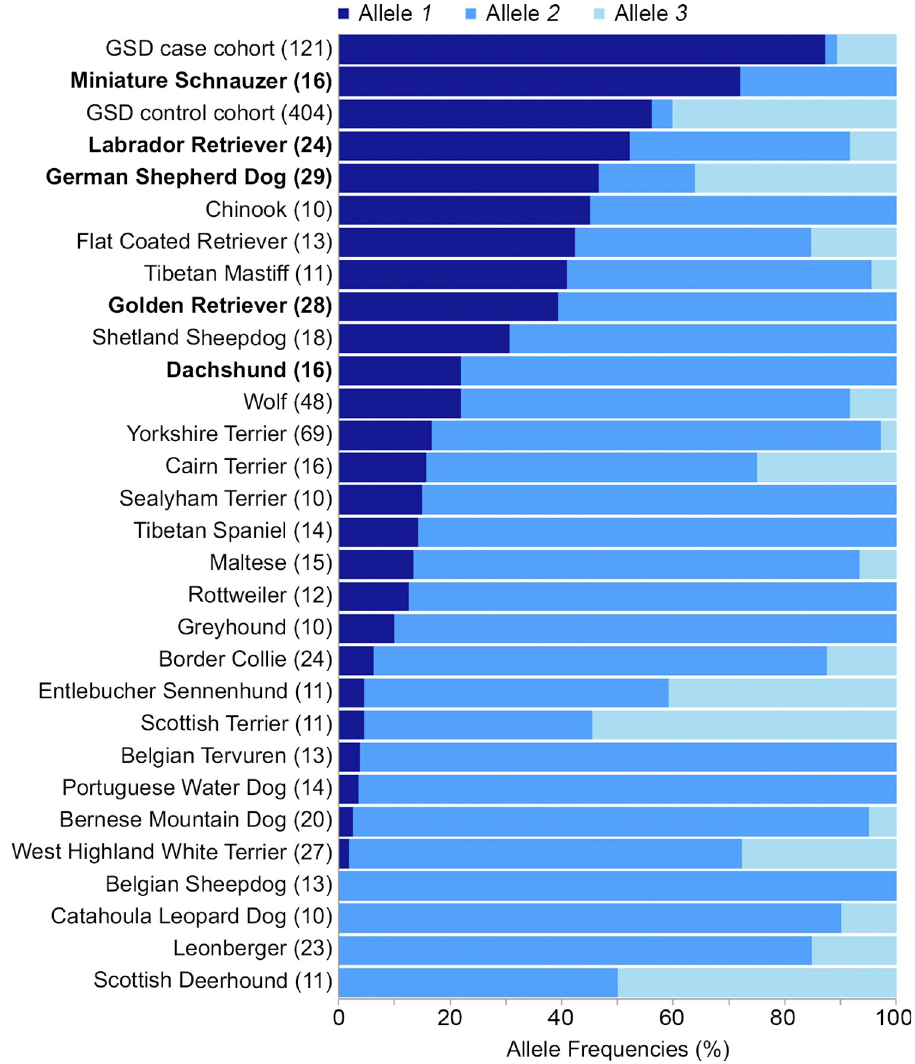
from publicly available WGS data), and wolves. The number of individuals of each breed is shown in parentheses. Breeds having high incidences of CIM are bolded